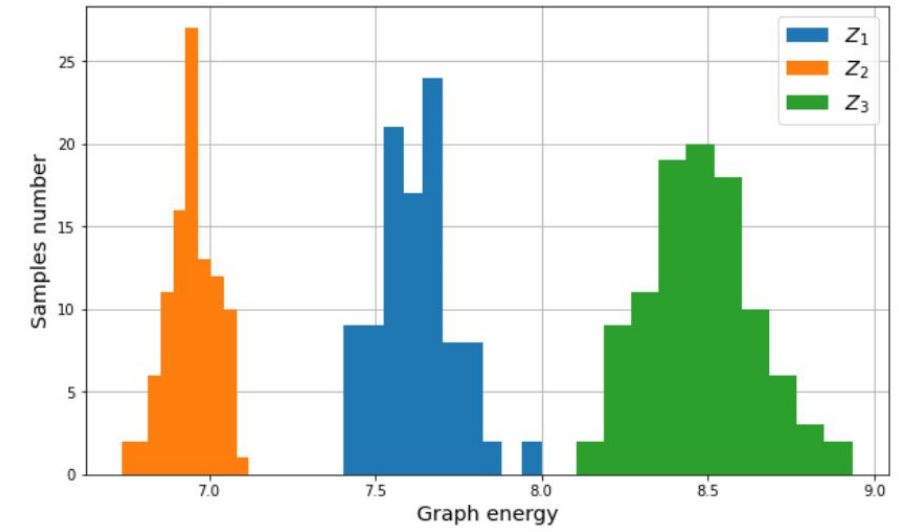
Figure 7. Calculated energy values for classes Z 1 , Z 2 and Z 3 .